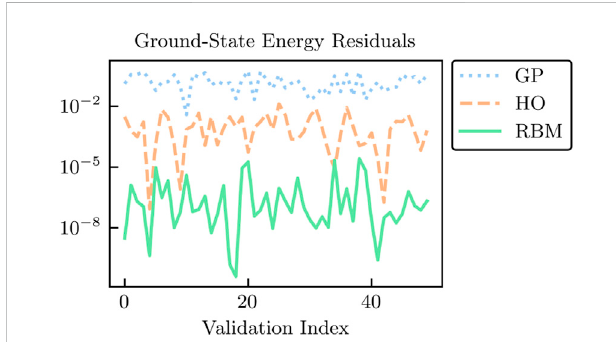
FIGURE 6 Absolute residuals in the energy (in MeV) at the 50 validation points for the RBM, HO, and GP emulators. The validation points are chosen randomly from a uniform distribution within the same range as the training points. See the main text for